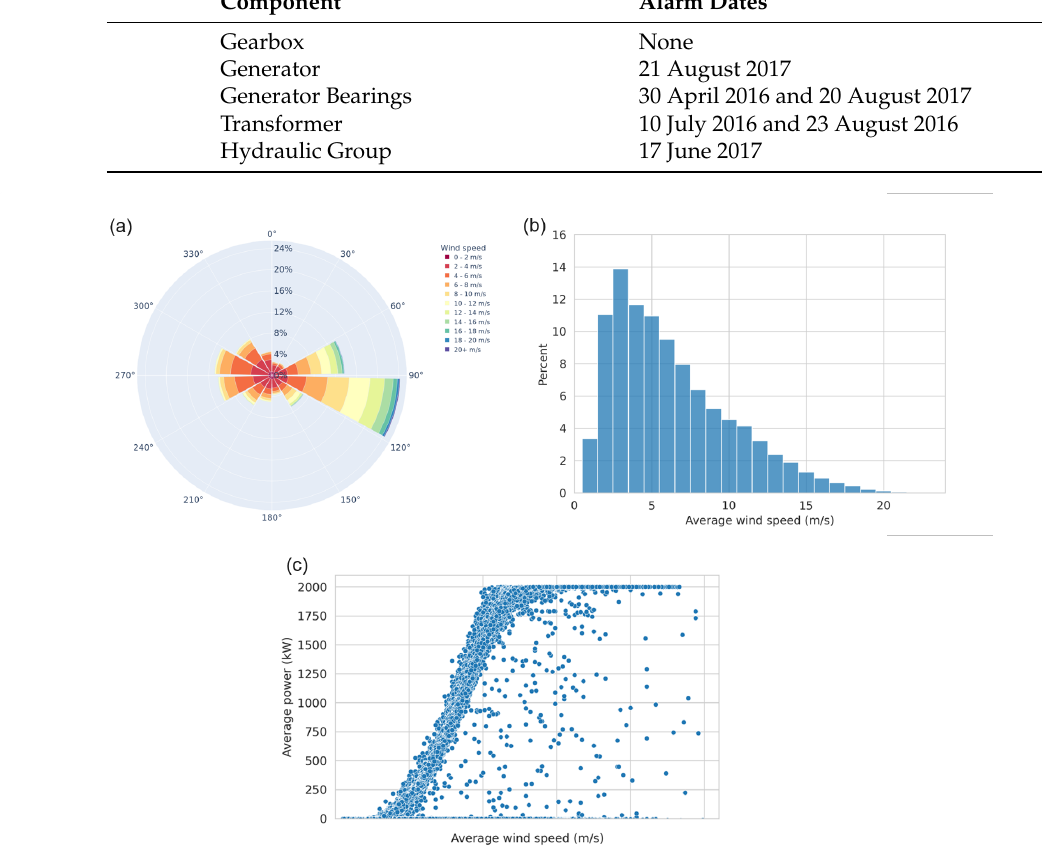
Table 1. Annotated failures provided by EDP for WT07.